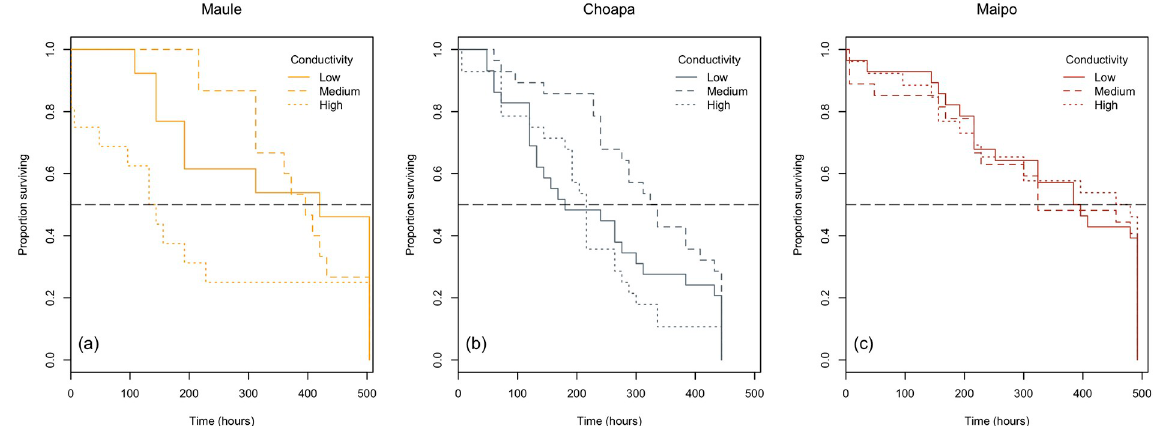
Fig 2. Survival curves. Kaplan-Meir survival curves of S. annulicornis from populations belonging to Choapa, Maipo and Maule river basins subjected to conductivity treatments. Doted black line indicate the 50% of survival.